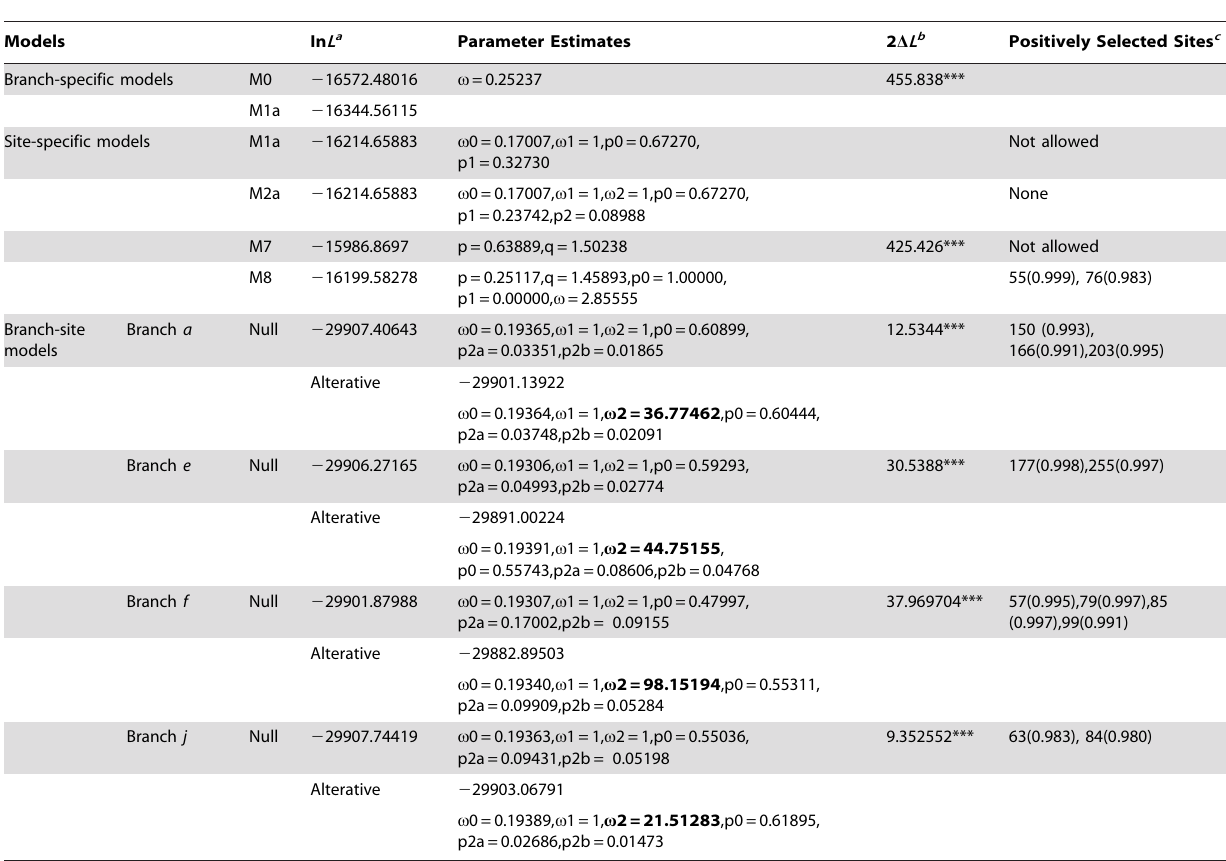
Table 2. CODEML analyses of selective pattern for M35 family